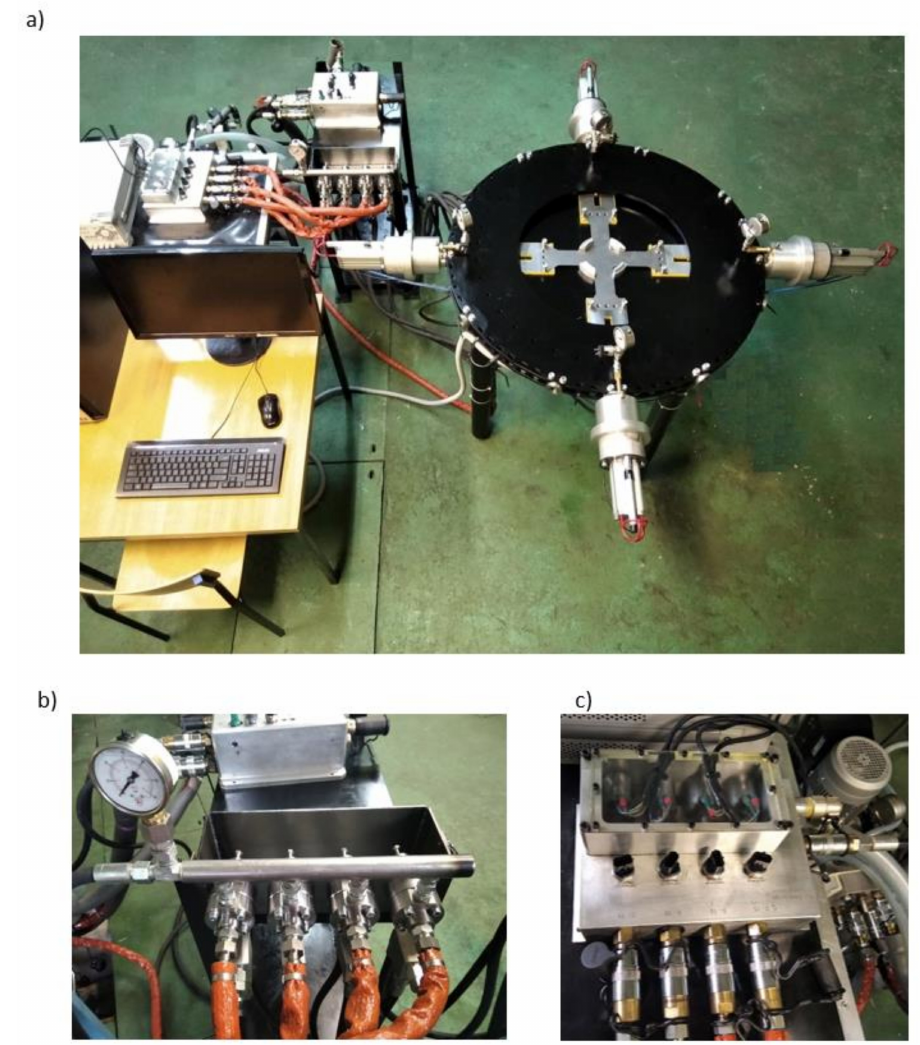
Figure 8. Test bench for biaxial tensile tests: ( a ) Biaxial tensile test machine, ( b ) four flow adjustable valves, ( c ) PWM electro-valves.